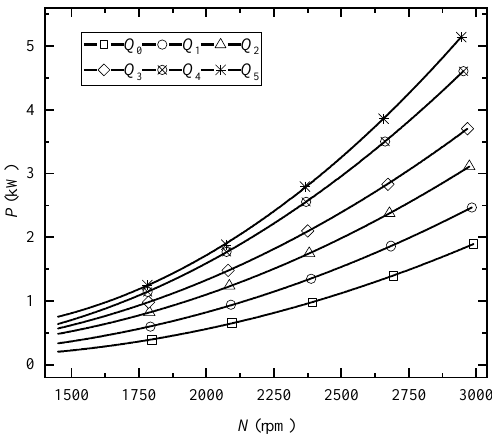
Figure 8. PN curves.